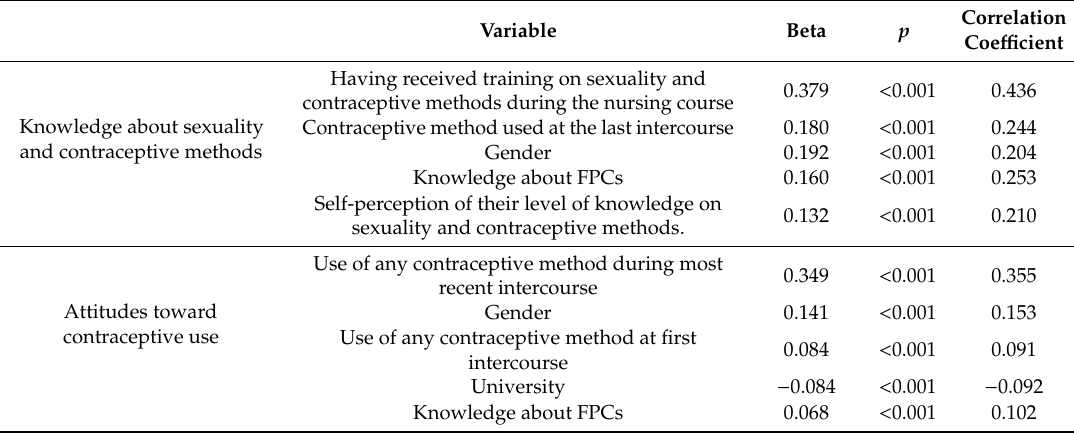
Variable Beta p